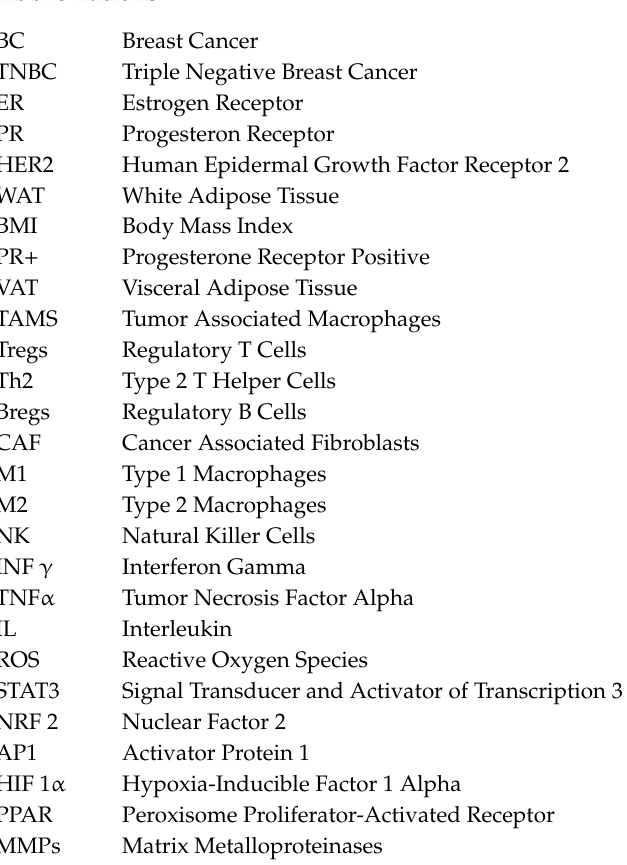
title: “Increasing the performance of scientific research and technology transfer in translational medicine through the formation of a new generation of young researchers” - ECHITAS, grant ID: 29PFE / 18.10.2018; by Ministry of Research and Innovation, Romania, project title: “Sustenance and valorification of research of excellence in the domain of personalized medicine by inter-nationalization and increasement of research activities visibility”—CNFIS-FDI, grant ID: CNFIS-FDI-2019-066; and by Unit for Financing Higher Education, Research, Development and Innovation (UEFISCDI), project PN-III-P1-1.2-PCCDI-2017-0782, entitled “Advanced innovative approaches for predictive regenerative